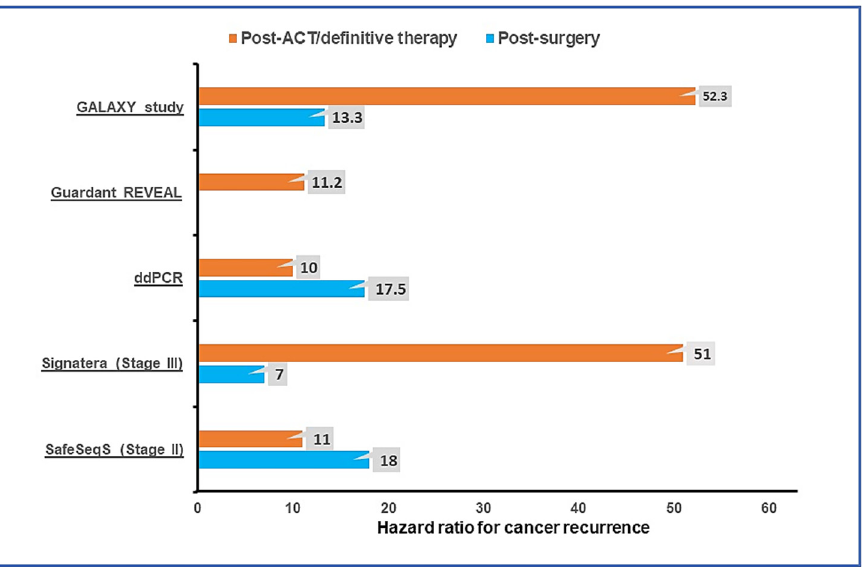
Figure 1. Risk of cancer recurrence reported in prospective observational studies with positive ctDNA in the post-operative and post-adjuvant therapy/definitive therapy settings utilizing tumor- agnostic Guardant REVEAL [28] and tumor-informed ctDNA assays (ddPCR [30] , Signatera [27] , and SafeSeqS [55] , GALAXY study [62] ). ACT, adjuvant chemotherapy; ddPCR, droplet digital pol- and SafeSeqS [55], GALAXY study [62]). ACT, adjuvant chemotherapy; ddPCR, droplet digital ymerase chain reaction. polymerase chain